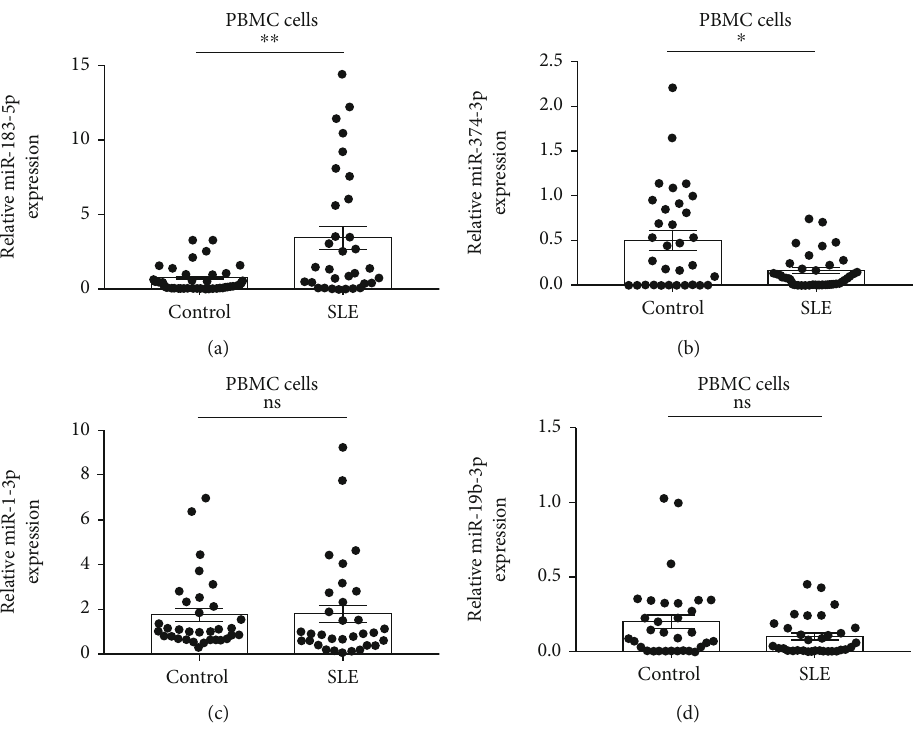
Figure 4: Expression levels of candidate miRNAs in SLE cases and controls in the validation phase. The expression level of miRNA was determined using qPCR from each group. Our data found that miR-183-5p was upregulated (a) and miR-374b-3p was downregulated (b). However, no signi fi cant di ff erence was exhibited with regard to miR-1-3p (c) and miR-19b-3p (d). ns: p > 0 : 05 ; ∗ p < 0 : 05 ; ∗∗ p < 0 : 01 .